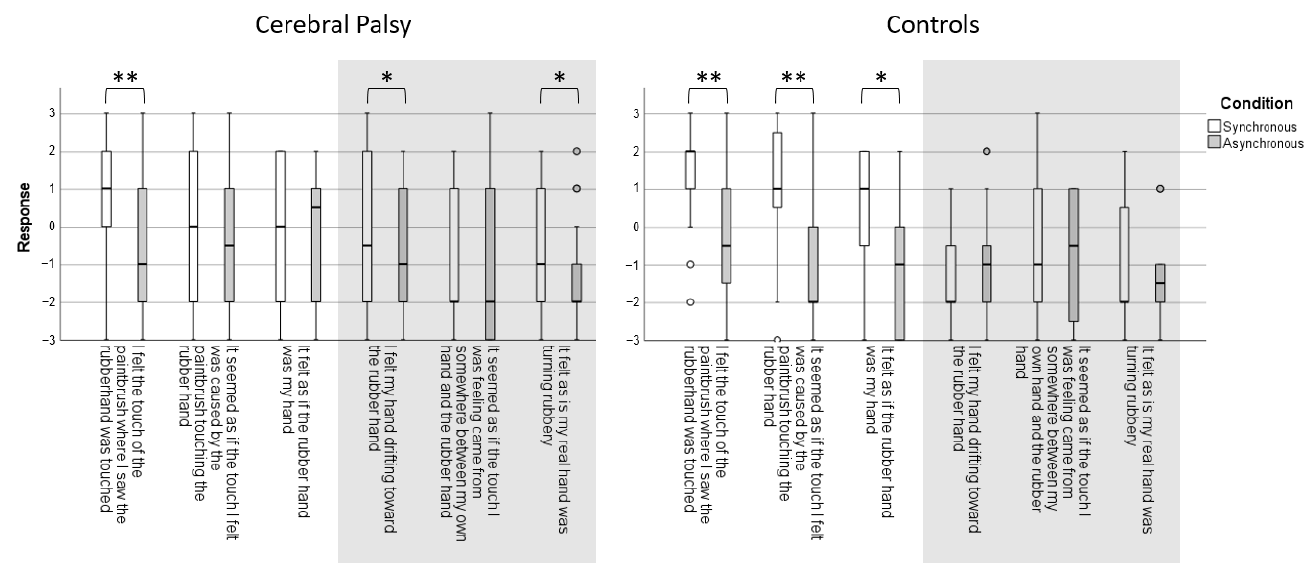
Figure 3. Subjective ratings of hand ownership in teenagers with unilateral cerebral palsy and typically developing teenagers. Responses to statements on subjective body ownership were given on a 7-point Likert scale ranging from “do completely agree” +3 to “do not agree at all” − 3, where 0 corresponded to neither agreeing nor disagreeing. Greyed areas indicate control statements. Significant differences are indicated as follows: * p < 0.05, and ** p < 0.01. The results of the clinical co-factors are displayed in Table 1. There were no signifi- cant correlations between the clinical co-factors and PD. Table 1. Clinical measures of motor and sensory function and correlations with proprioceptive drift of the affected hand in teenagers with unilateral cerebral palsy.